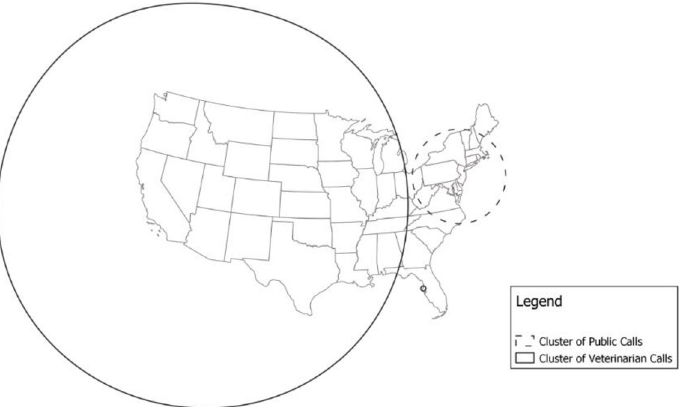
Fig 2. Results of the purely spatial scan of the entire study period (2005–2014), clusters with solid lines represent higher than expected veterinarian calls and dashed clusters represent higher than expected public calls.